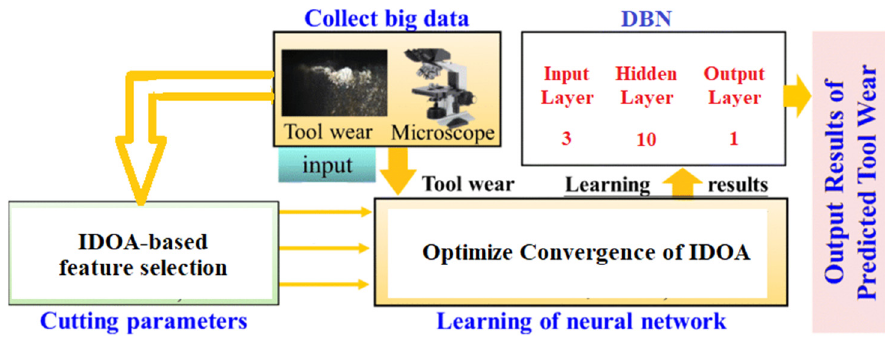
Figure 4. Architecture of the IDOA-DBN process.